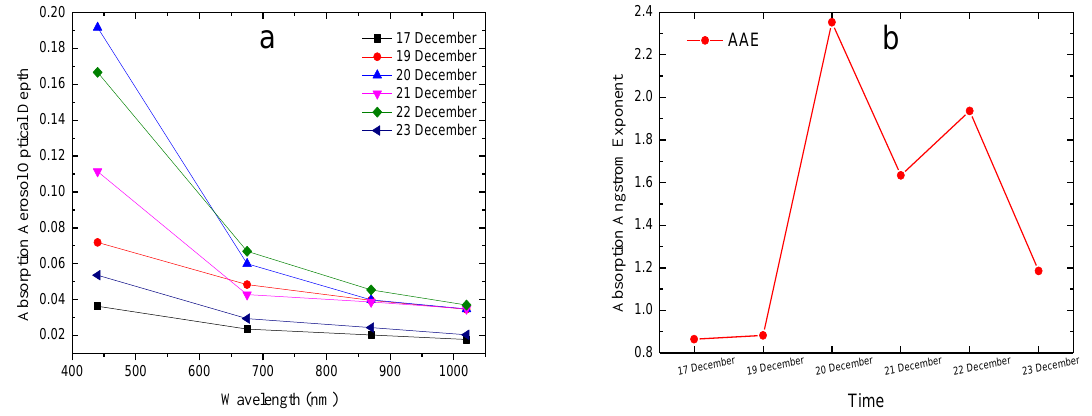
Figure 8. The daily averages of AAOD at different wavelengths and AAE measurements at Beijing